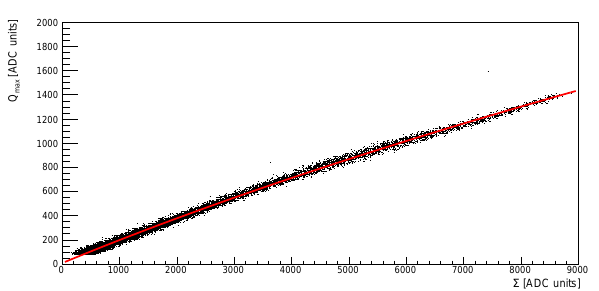
Figure 4: Correlation between the maximum value and the sum.